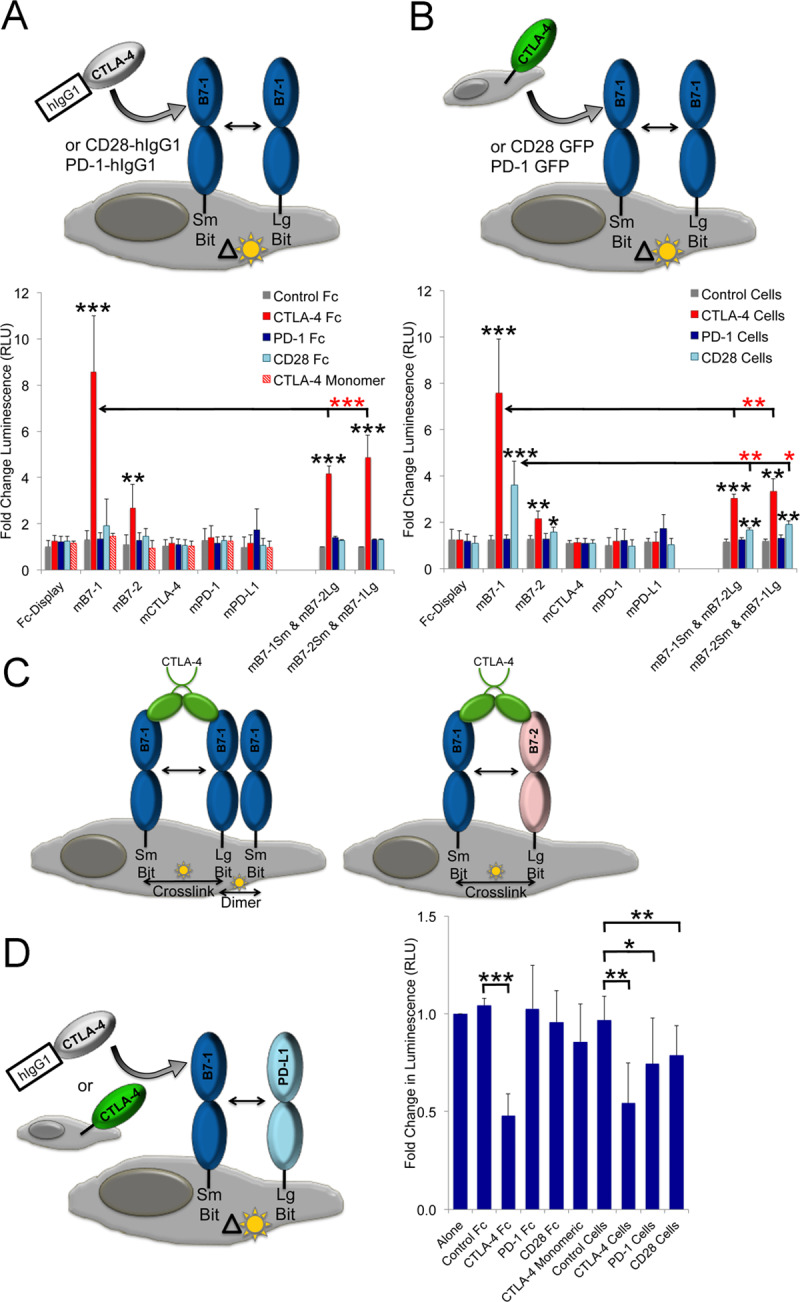
Reorganization of cell surface B7-1 inhibits the cis interaction between PD-L1 and B7-1.A) HEK 293 freestyle cells were co-transfected with SmBit and LgBit constructs as indicated. Two days post transfection 100,000 cells were incubated with 0.5 μg of recombinant CTLA, CD28 or PD-1 or control Fc-fusion protein in 150 μL reaction volume. After binding for 1 hour at room temperature a 50 μL aliquot from each binding reaction was removed and 12.5 μL of nanoluciferase substrate added. Data shows the fold change calculated as the ratio of stated condition to untreated cells and represents 8 independent experiments with standard deviations. B) Same as in A) except that 50,000 HEK 293 cells expressing either CTLA-4 GFP, CD28 GFP or PD-1 GFP or control were added as indicated. C) Same as in A) and B) except querying HEK 293 cells transiently transfected with B7-1 SmBit and PD-L1 LgBit constructs. Significance calculated by one-way Annova is indicated by stars, *** = P <0.001, ** = P<0.01 and * = P<0.05.